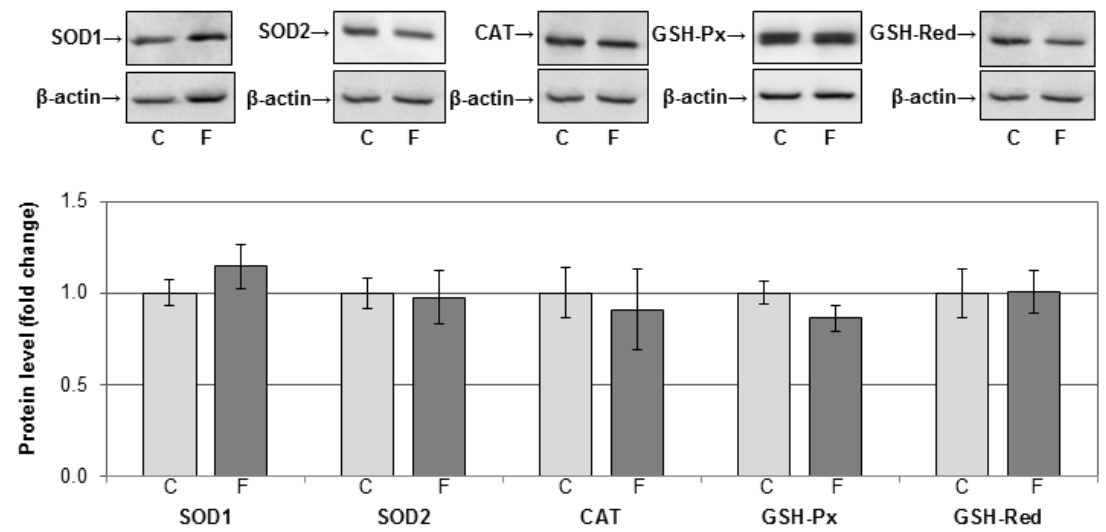
Figure 7. The effects of a fructose-rich diet on the level of antioxidant enzymes in the liver. Hepatic whole cell extracts (50 µg protein) were subjected to SDS-PAGE and Western blotting. Relative integrated optical density was assessed by ImageQuant software. β-actin was used as loading control. Representative Western blots and relative quantification of antioxidant enzyme protein levels of control (C) and fructose-fed rats (F) are shown. Values are means ± SEM ( n = 9) and are presented as fold of the control. SOD1, cytoplasmic copper-zinc superoxide dismutase; SOD2, mitochondrial manganese superoxide dismutase: CAT, catalase; GSH-Px, glutathione peroxidase; GSH-Red, glutathione reductase.